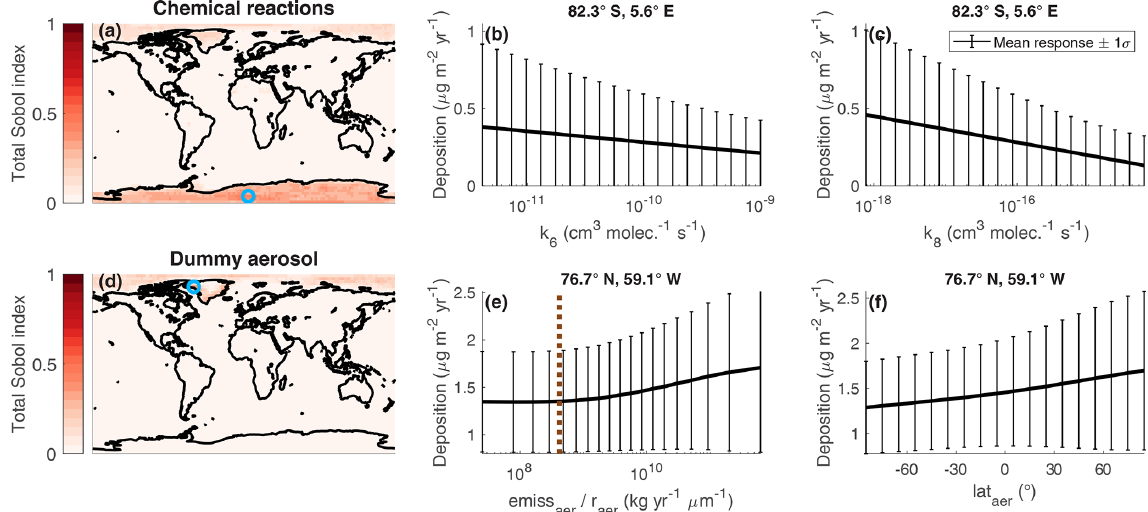
Figure 10. Maps of the total Sobol’ indices of reaction rate constants and dummy aerosol parameters for total Se deposition (a, d) . A blue circle indicates the grid box where the aggregated total Sobol’ index is at a maximum. The relationship between total Se deposition and the multiple relevant input parameters within the aggregated index for that grid box is shown (b, e) . The emitted dummy aerosol surface area is compared to the corresponding sulfate quantity in the latitude band of the grid box, shown as a dashed brown line in (e) .